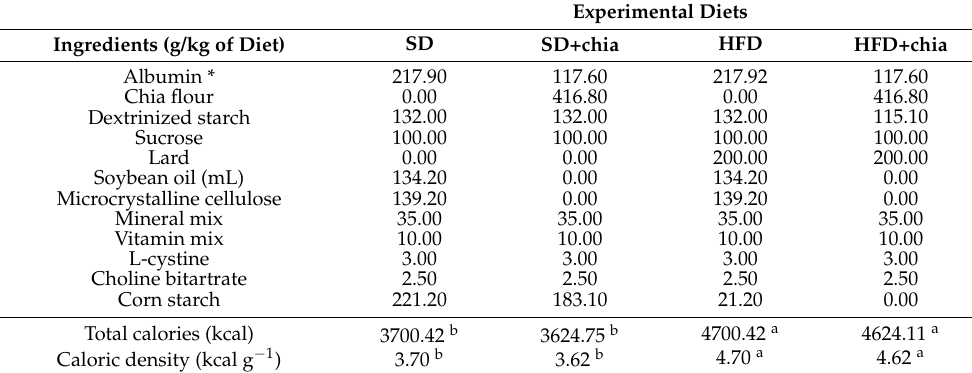
Table 1. Compositions of the experimental